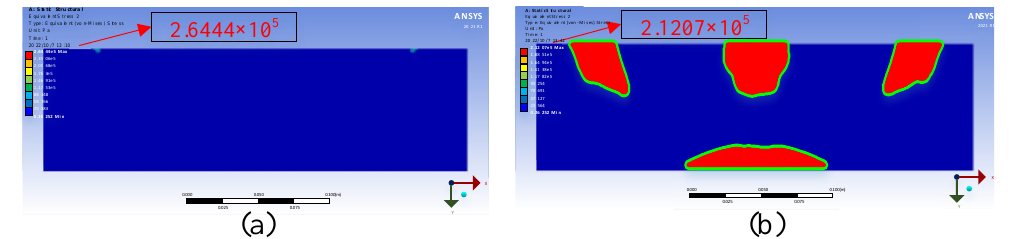
Figure 12. Simulation result by ANSYS, ( a ) Young’s modulus = 2; ( b ) Young’s modulus = 3 in red